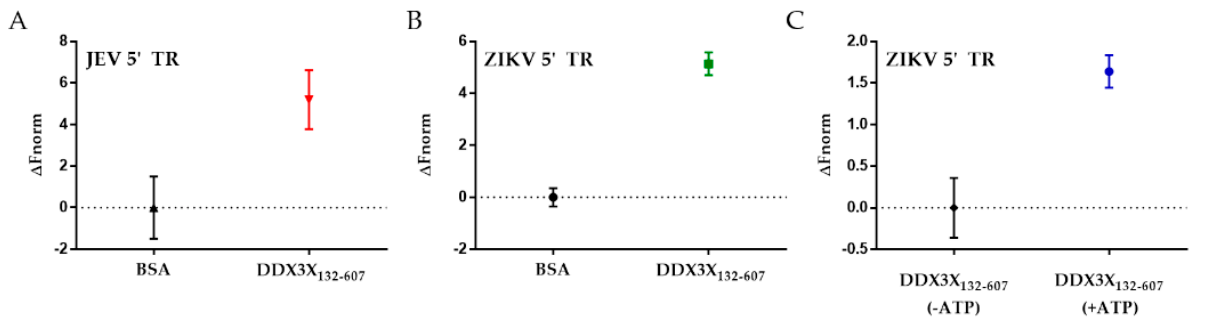
Figure 4. Helicase assays conducted using microscale thermophoresis (MST). ( A ) Comparing the change of fluorescent migration of a complementary DNA oligo in the presence of 5 (cid:48) TR of JEV with ATP and either bovine serum albumin (BSA) or DDX3X 132–607 . The average signal to noise ratio is 14.8 ± 4.82 ( n = 3). ( B ) Comparing the fluorescent migration of a complementary DNA oligo in the presence of ZIKV 5 (cid:48) TR with ATP and either BSA or DDX3X 132–607 . The average signal to noise is 20.0 ± 5.06 ( n = 3). ( C ) Investigating the role of ATP in DDX3X 132–607 helicase activity. The average signal to noise ratio is 5.5 ± 0.59 ( n = 3), suggesting that ATP is required to unwind